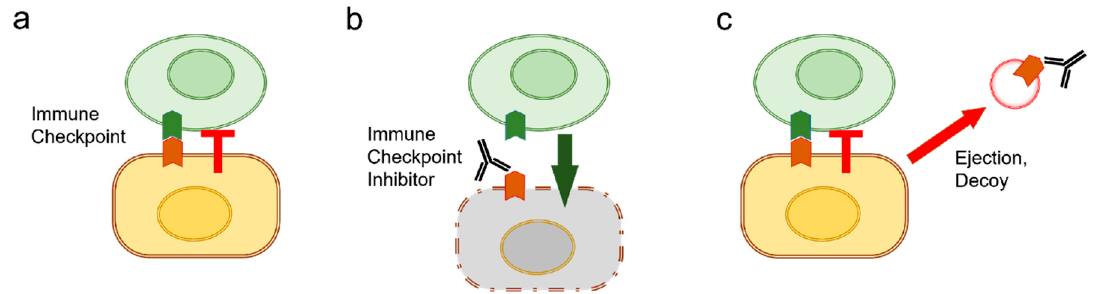
Figure 4. Role of EV release in immune evasion. ( a ) The immune checkpoint enables cancer cells to evade killing by cytotoxic T cells. For example, cancer cells express PD-L1 (shown in dark brown) that binds with PD-1 (shown in dark green) on the surface of immune cells and acts as a co-inhibitor of the T cell receptor. ( b ) Immune checkpoint inhibitors can block the checkpoint and enable immune cells to attack cancer cells. ( c ) However, cancer cells could eject immune checkpoint inhibitors by releasing EVs that contain checkpoint